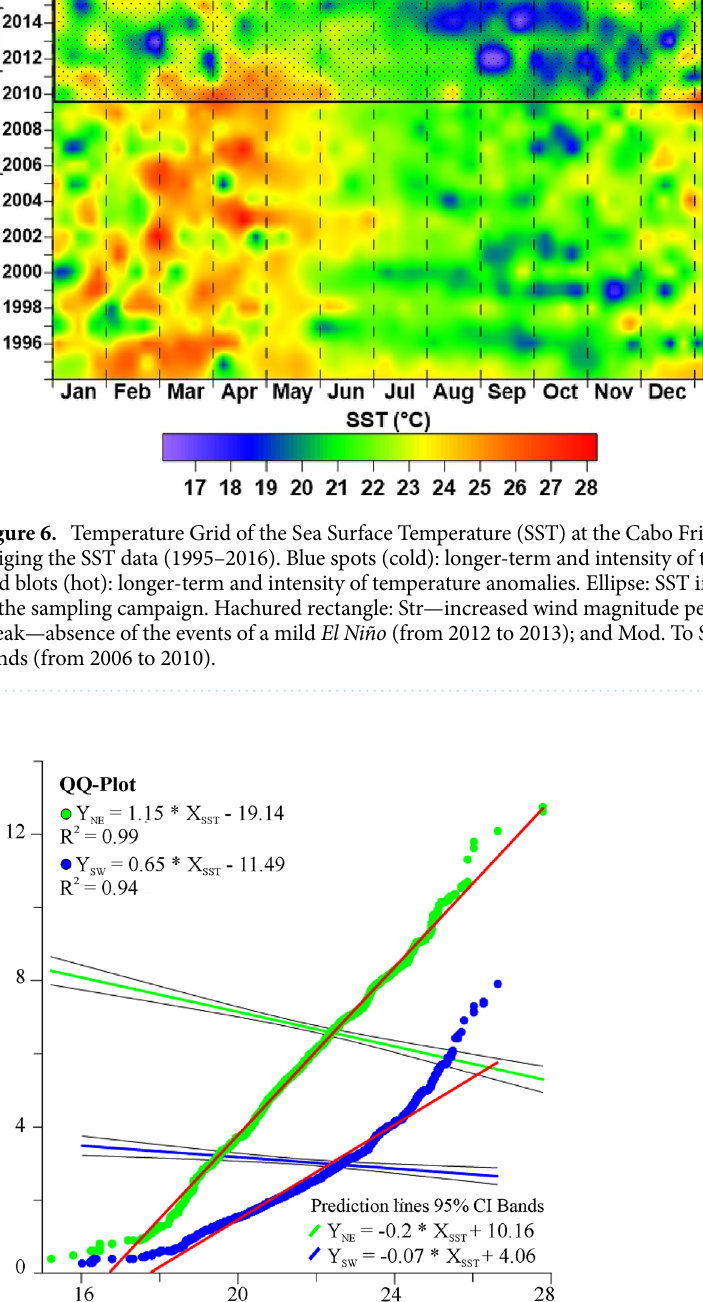
directions (R 2 NE = 0.99 and R 2 SW = 0.94). In addition, the linear regression showed that the lower the SST, the greater the wind speed (Fig. 7). The SST data and El Niño and La Niña presented in Fig. 6, which pointed to an influence on the wind pattern in the Cabo Frio upwelling area (Fig. 5), may be related to the movement of lunar nutation. The most evident